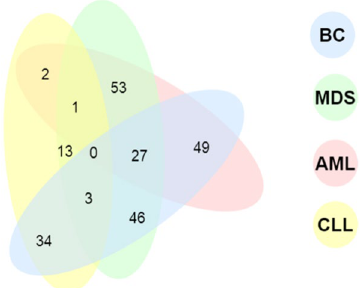
Figure 9. Venn diagram shows the number of common patients among each possible combination within the four cancer types. All data are reported except the number of patients having AML, CLL, and BC as zero.